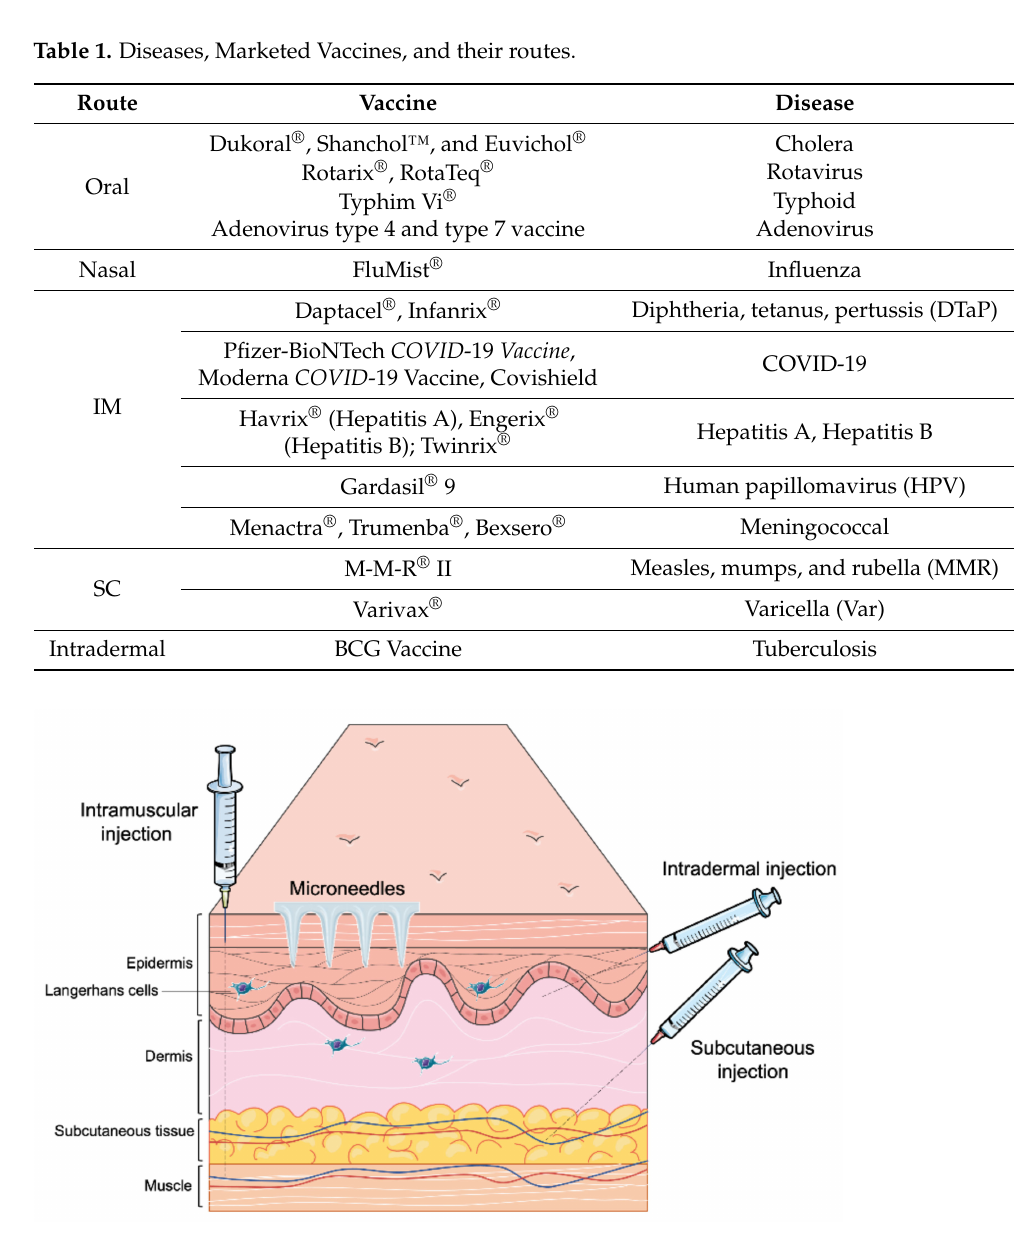
Figure 2. Different parenteral routes of vaccine